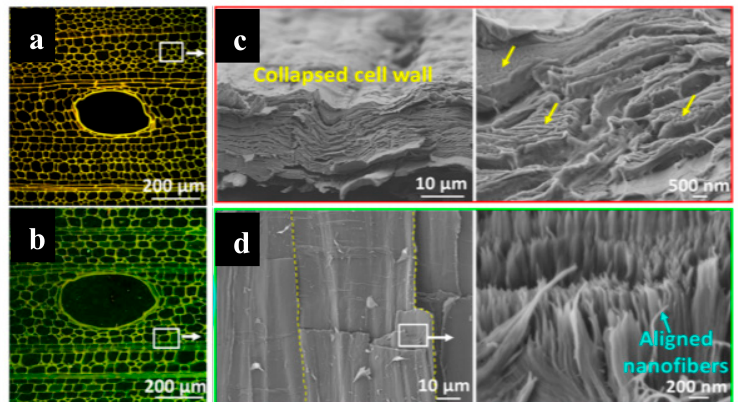
Figure 5. Confocal microscopy images at ×200 magnification for ( a ) untreated and ( b ) treated wood. ( c ) SEM images of a thin wood film cross-section, showing a lamellar structure of collapsed cell walls. Yellow arrows point toward lamellar cross-sections. ( d ) SEM images showing a single fiber (contoured in yellow) and cellulose microfiber bundles and nanofibrils (blue arrow). Adapted from [56]